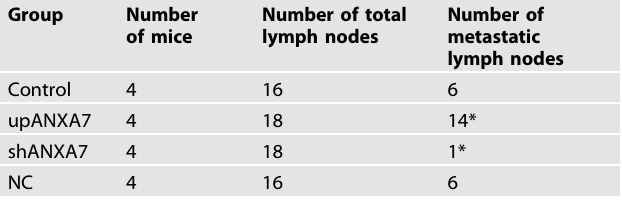
Table 1. Effect of ANXA7 on a metastatic lymph node in